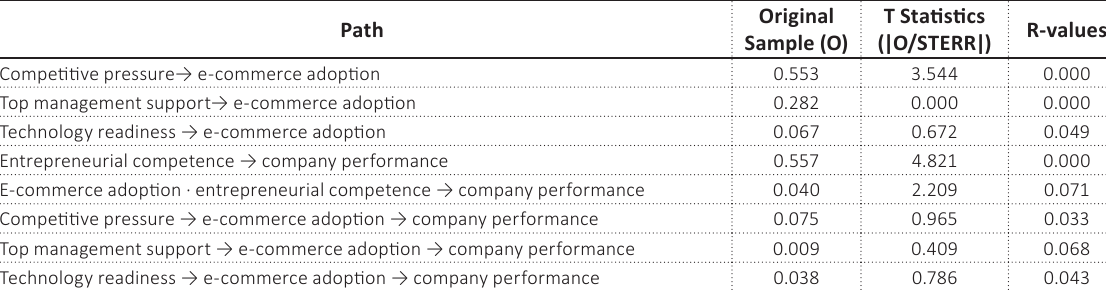
Table 3. Statistical path analysis